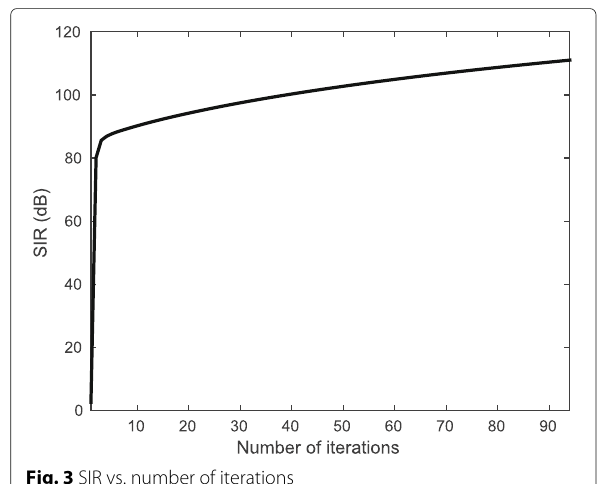
Fig. 3 SIR vs. number of iterations